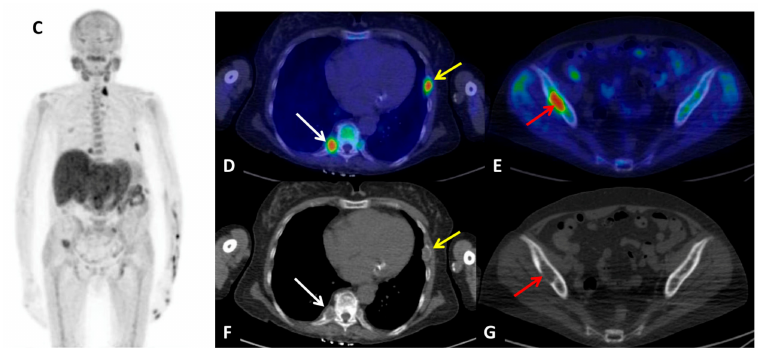
Figure 4. 18 F-FCH PET / CT delayed whole-body acquisition ( C ) demonstrated radiotracer uptake in multiple bone lesions, the most evident in the right D5 costovertebral joint ( D ) (white arrow) and in the left 6th rib ( D ) (yellow arrow), as well as in the right iliac wing ( E ) (red arrow). Their metabolic and morphological ( F , G ) aspect were compatible with renal osteodystrophy. A few days later, patient underwent subtotal parathyroidectomy. Three parathyroid glands were removed: two of 20 mm size each at the upper and lower poles of the left thyroid lobe respectively, the third of 15 mm size at the lower pole of the right lobe. The histological examination reported a definitive diagnosis of “parathyroid hyperplasia with chief and oxyphilic cells, nodular pattern”. The day after subtotal parathyroidectomy the biochemical values were: PTH level 16 pg / mL (normal range 15–57 pg / mL), total calcium level of 6.2 mg / dL (normal range 8.5–10.1 mg / dL), ionized calcium level of 2.88 mg / dL (normal range